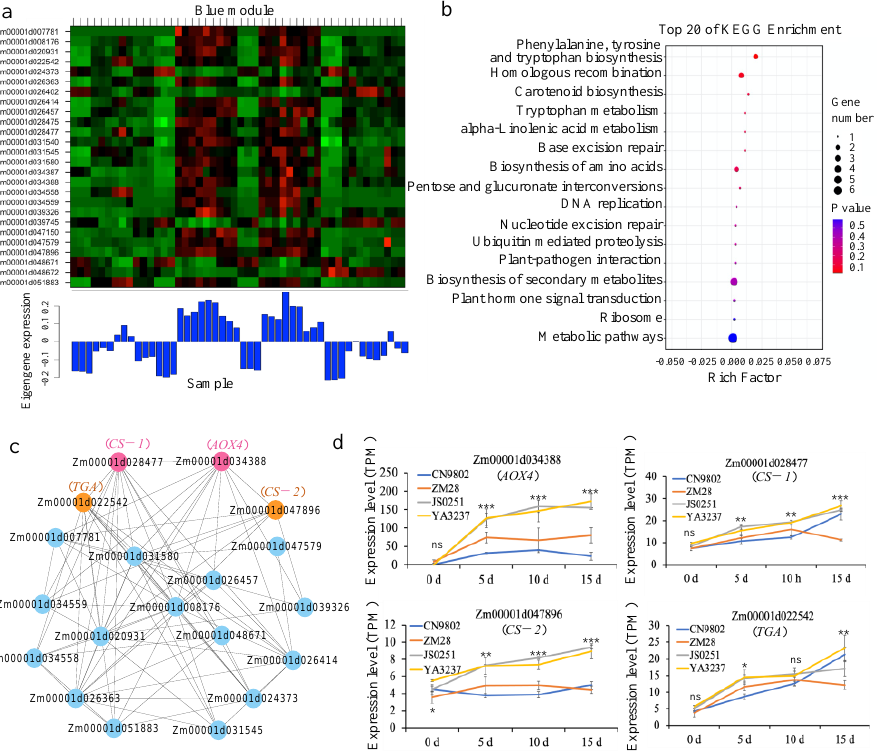
Figure 4. Gene co-expression network and hub genes responsible for maize embryogenic callus induction. ( a ) Eigengene expression pattern of the embryogenic callus induction-associated module (blue). Upper panel shows the gene expression heat map; lower panel shows the eigengene expression histogram. ( b ) Top 20 enriched pathways in blue module. ( c ) Co-expression network of hub genes. The four hub genes are shown in pink and orange. ( d ) The expression patterns of the four hub genes during embryogenic callus induction. CN9802, ZM28, JS0251, and YA3237 represent four different maize inbred lines. The significance of difference between each pair of these lines was estimated by using a t -test (2-tailed), with n = 3 (three biological replicates). *, **, and *** represent significant difference at p = 0.05, p = 0.01, and p = 0.001 levels, respectively, at least between one pair of the four lines, for each stage. ns = not significant. The bars show the standard deviation (SD).